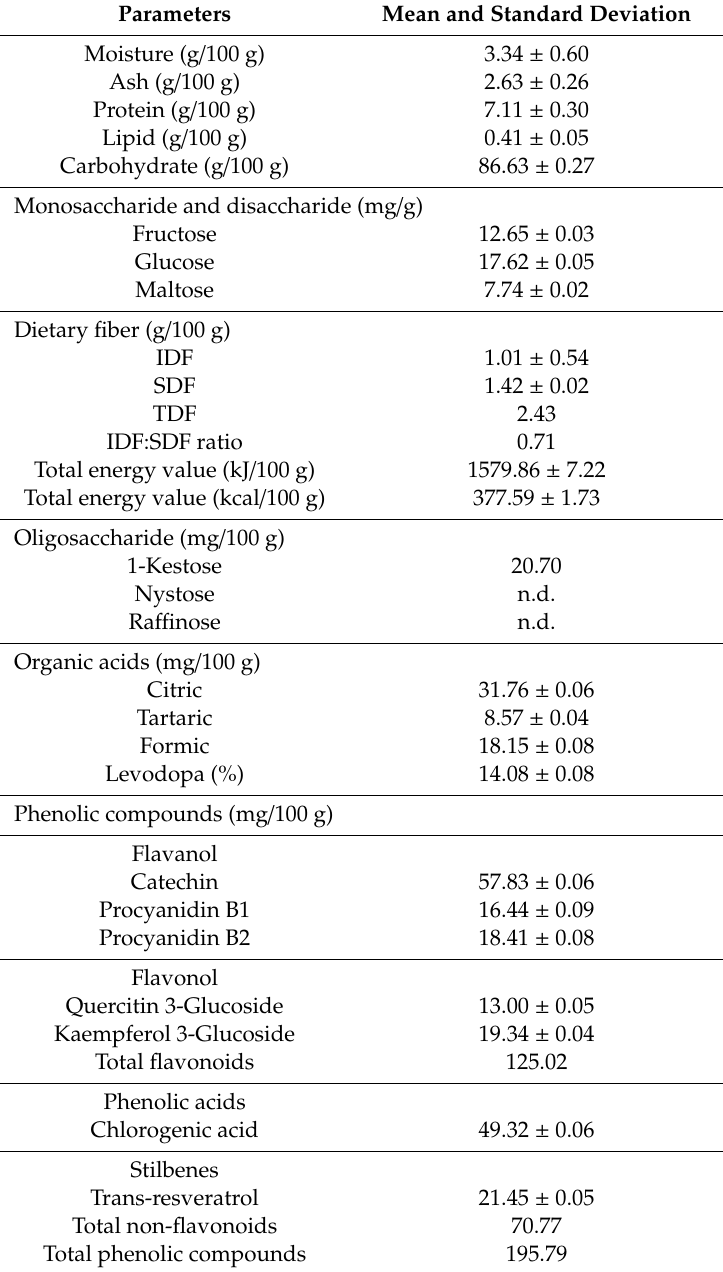
Table 1. Chemical composition of hydroalcoholic extract of Mucuna pruriens (MP)